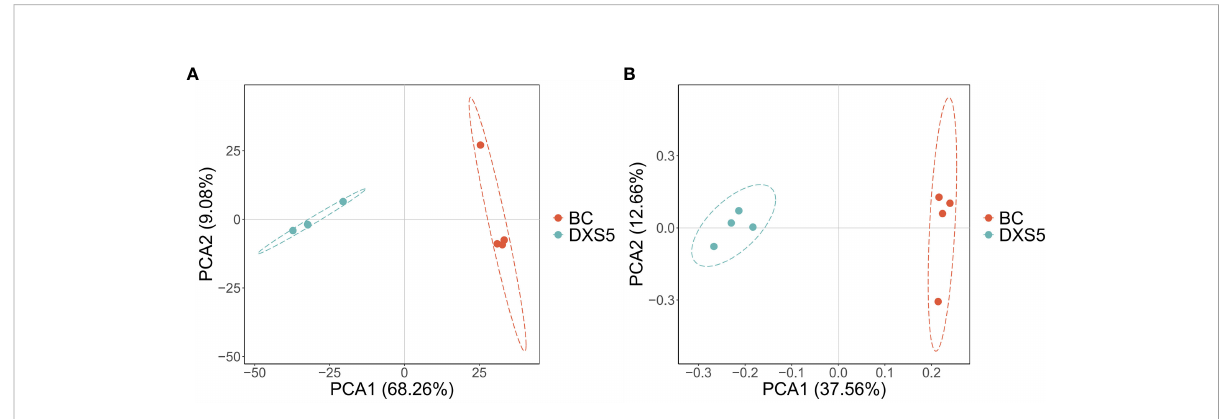
FIGURE 2 Principal component analysis (PCA) score plots. (A) Positive ion mode. (B) Negative ion